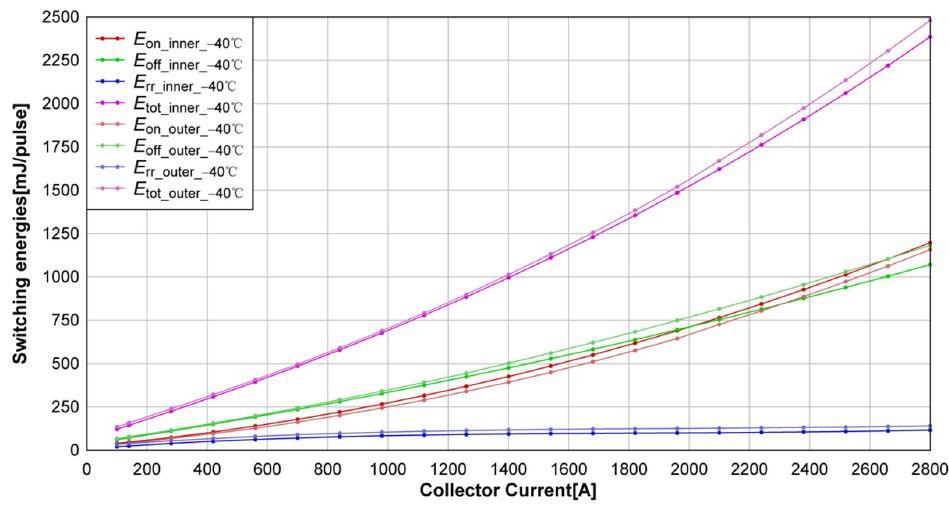
Figure 26. IGBT switching energies between the inner and the outer commutation paths at − 40 °C.